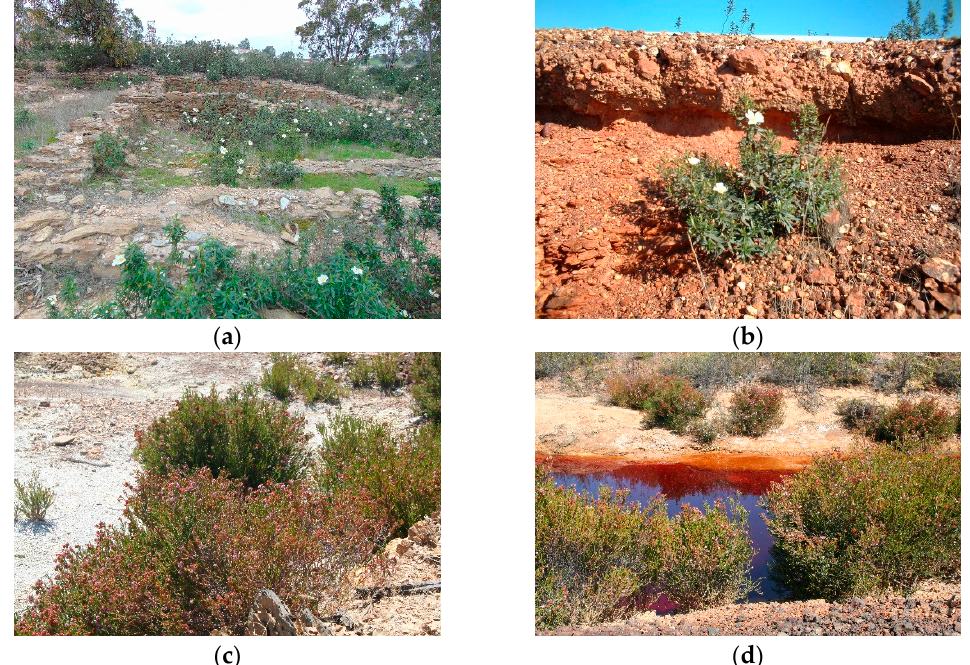
Figure 4. Native plant species found in mines in the Portuguese sector of the IPB: ( a ) Cistus ladanifer L. in Aljustrel mine and ( b ) in São Domingos mine; ( c ) Erica andevalensis in tailing deposits in the São Domingos mine and ( d ) close to AMD- affected streams in the São Domingos